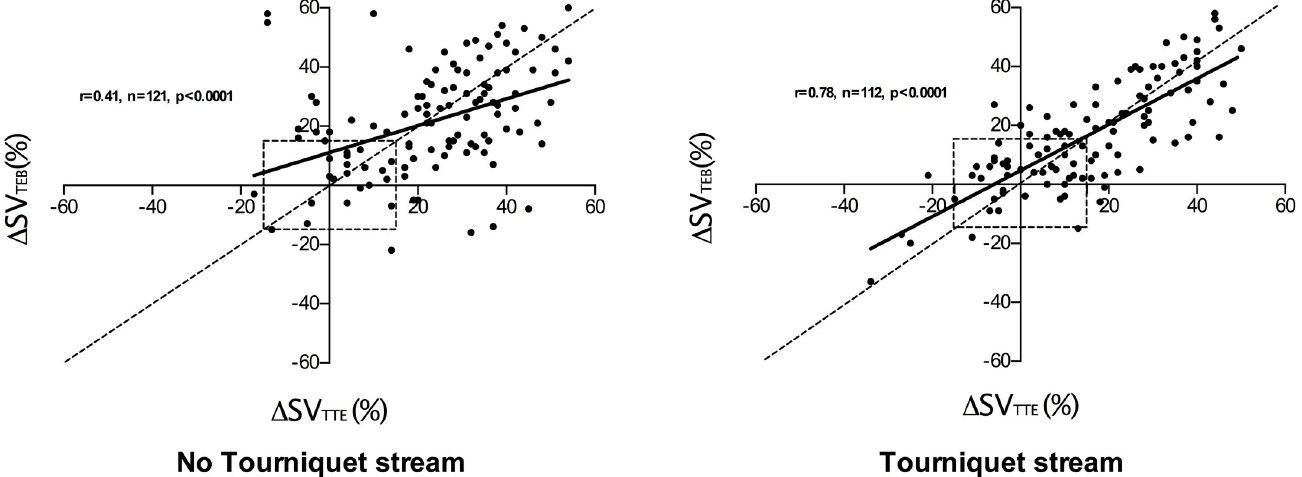
Fig 4. 4 quadrant plot showing changes in stroke volume from baseline ( Δ SV) recorded using trans thoracic bioimpedence (TBI) and trans-thoracic echocardiography (TTE). 15% exclusion zone shown as dotted central square. Line of identity (y = x) shown as dotted line and regression line shown as solid line. r value indicates degree of correlation (Pearson’s co-efficient).